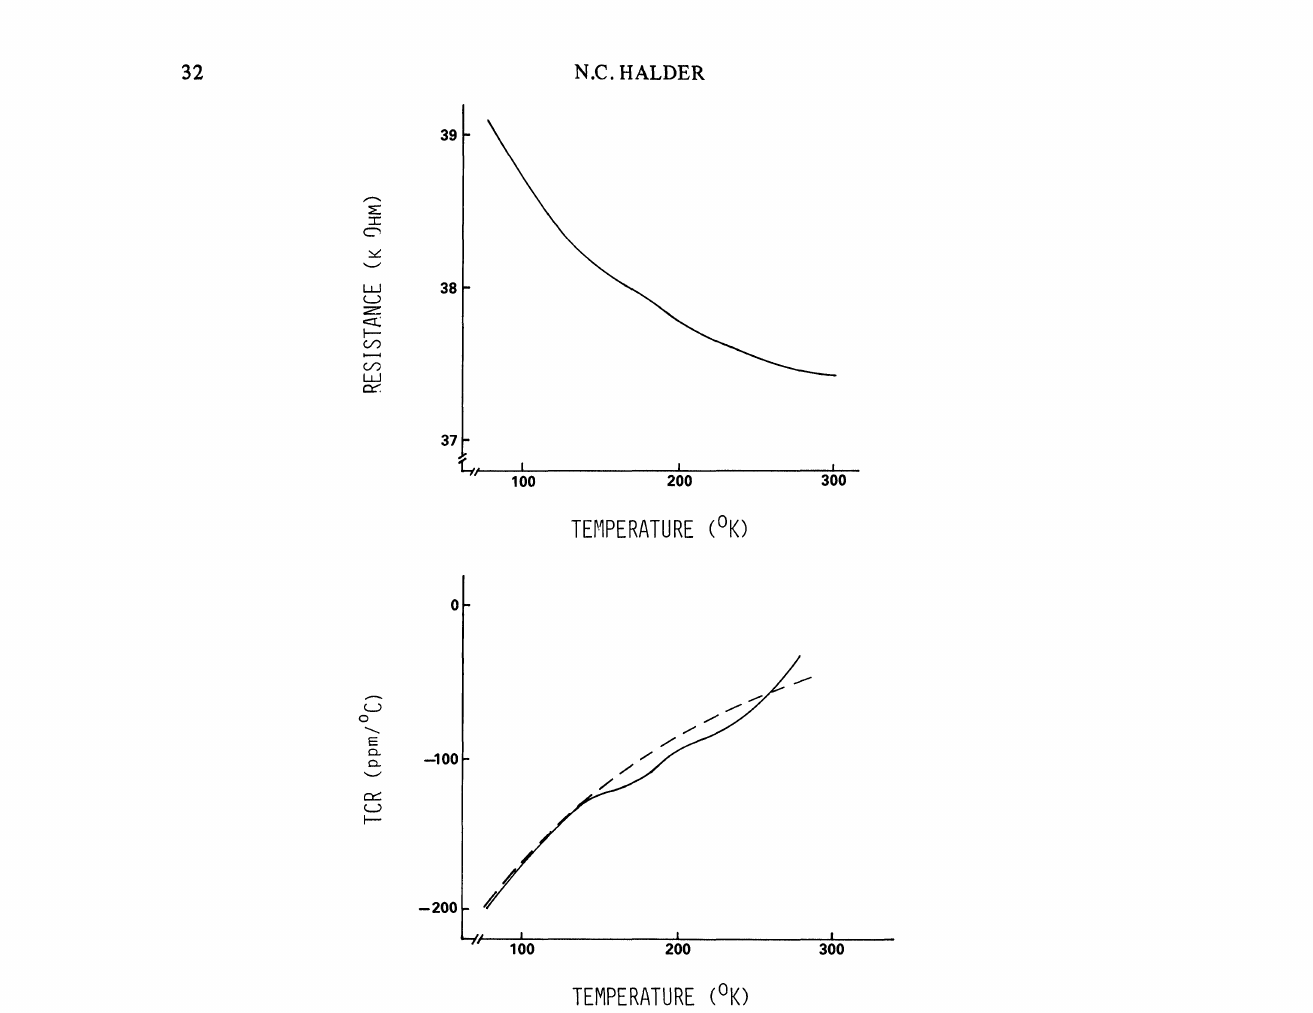
The experimental resistance and TCR data for RuO films as reported by Chen and Smith. 13 The dimensions of the films were 100 mil. X 200 mil. and 0.5 mil. thick. recent experimental work of Chen et al. is indicates a value for Tm 280K, where resis- tance is minimum for their RuO2 film. If we take this value of Tm to calculate the activa- tion energies we f’md, for ct 0.6, E from Pike-Seager equation. It would seem quite appropriate to quote the values which Pike and Seager 7 found in their work with RuO2 films determined from their measured